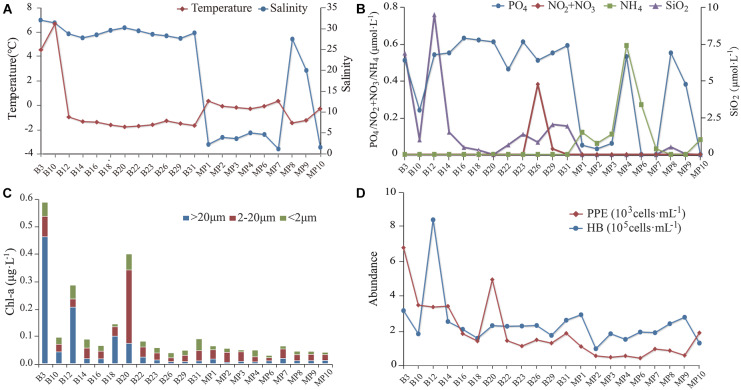
The environmental parameters measured at the sampling sites. (A) Water temperature and salinity. (B) Concentrations of NO2/NO3, PO4, NH4, and SiO2. (C) Size-fractionated chlorophyll a concentration. (D) Abundances of heterotrophic bacteria (HB) and pico-sized pigmented eukaryotes (PPEs).